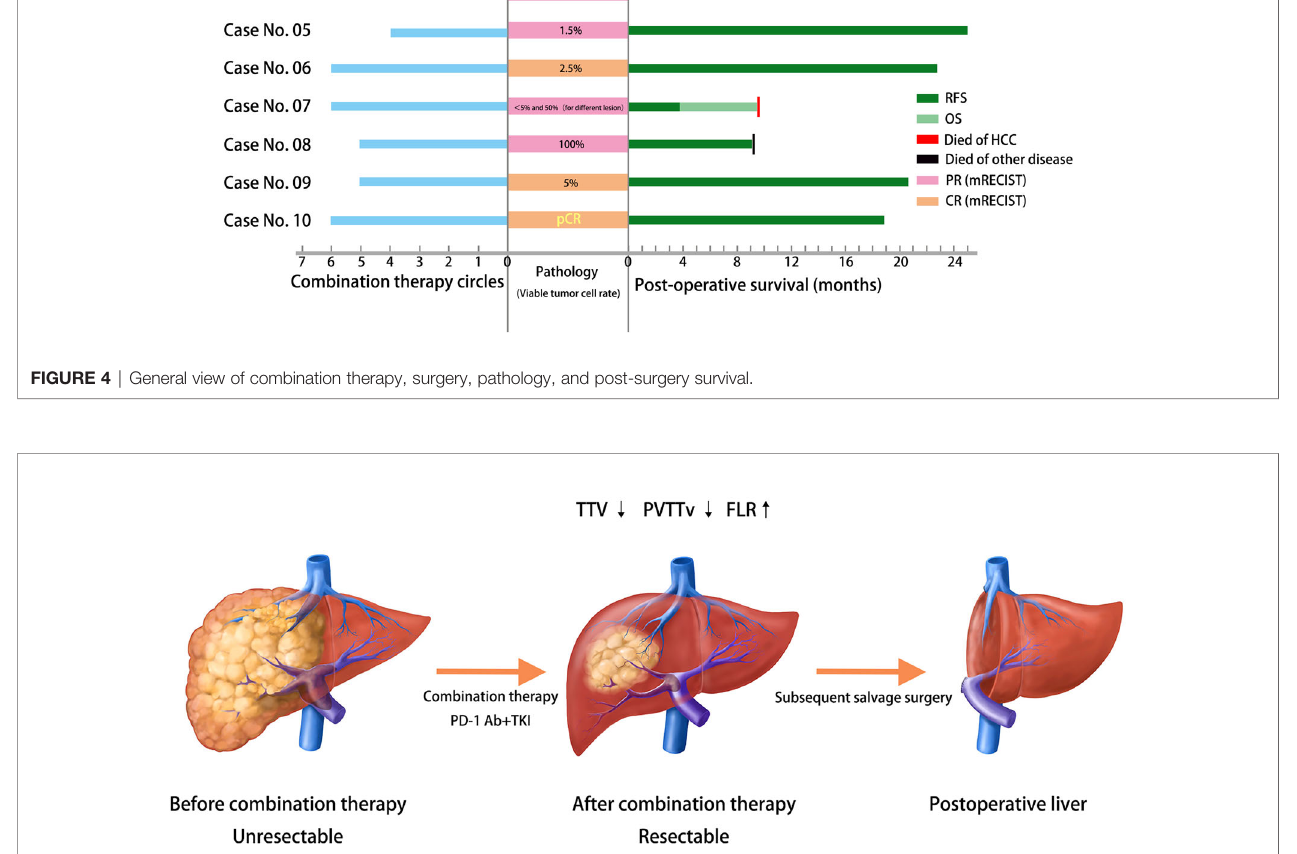
FIGURE 5 | Possibility of immunotherapy combined with targeted therapy as a conversion